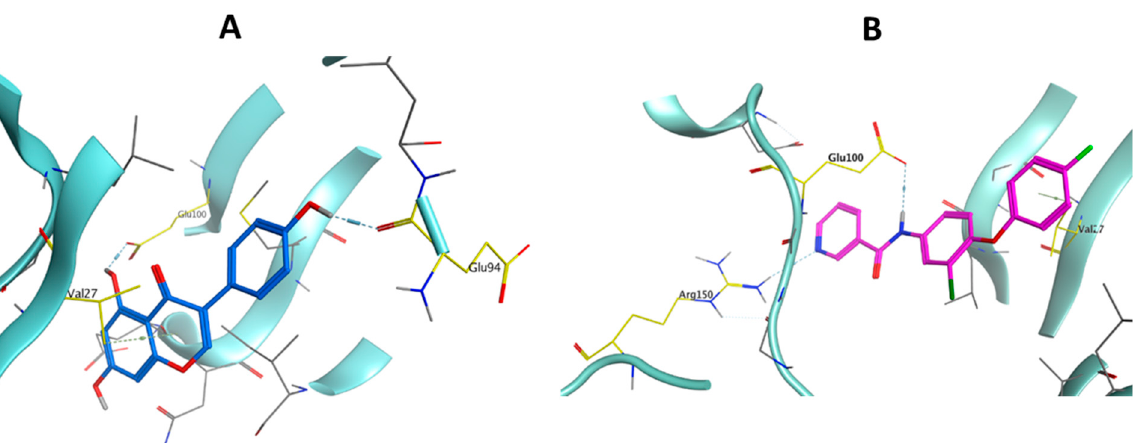
Figure 14. 3D representation of Genistein ( A ) and compound 4j ( B ) molecular interactions in the DAPK1 kinase.